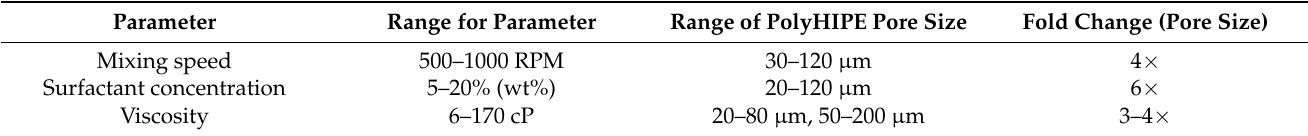
Table 4. Observed polyHIPE pore size ranges for various HIPE fabrication parameters including mixing speed, surfactant concentration, and viscosity.